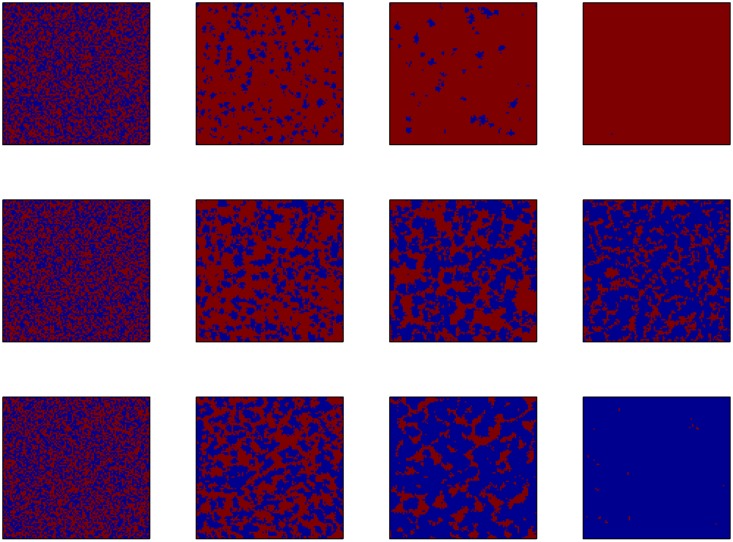
Snapshots of players’ strategies with parameters r = 2, T = 3 (the first row); r = 3, T = 2 (the second row) and r = 3, T = 3 (the third row).Blue pixels and red pixels represent the cooperative and defective strategy, respectively. The four columns show the results of the 1st, 10th, 30th and 10000th generations. The other parameter settings are θ = 20, K = 0.5 and μ = 10−4.